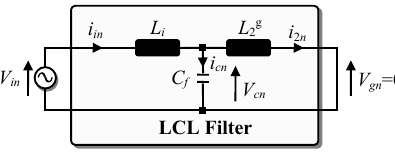
Figure 2. Single phase equivalent circuit with LCL filter at the n -harmonic.